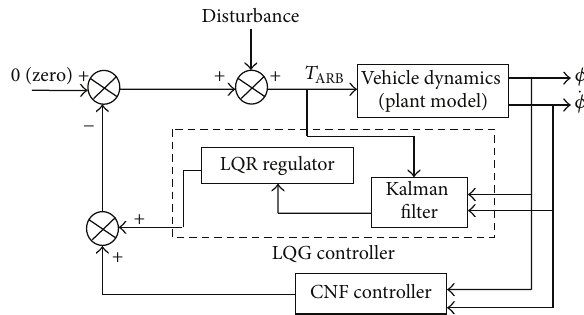
Figure 4: LQG CNF fusion block diagram